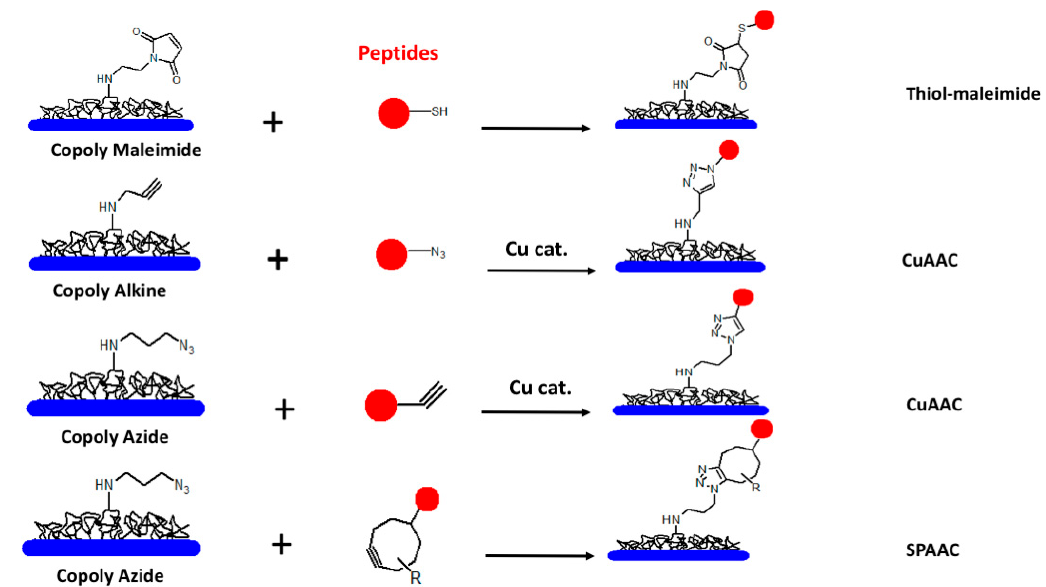
Figure 3. Family of clickable polymeric coatings generated from the common precursor Copoly (DMA-NAS-MAPS) to generate a polymeric platform for chemoselective peptide binding on microarrays. Modified peptides react by sulfhydryl-maleimide conjugation on Copoly maleimide; copper catalyzed azide-alkyne-cycloaddition (CuAAC) on Copoly alkine and Copoly azide; copper-free strain-promoted-azide-alkyne-cycloaddition (SPAAC) on Copoly Azide.